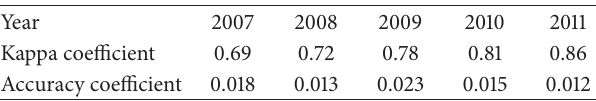
Table 3: The accuracy test of coastline extraction in China from 2007 to